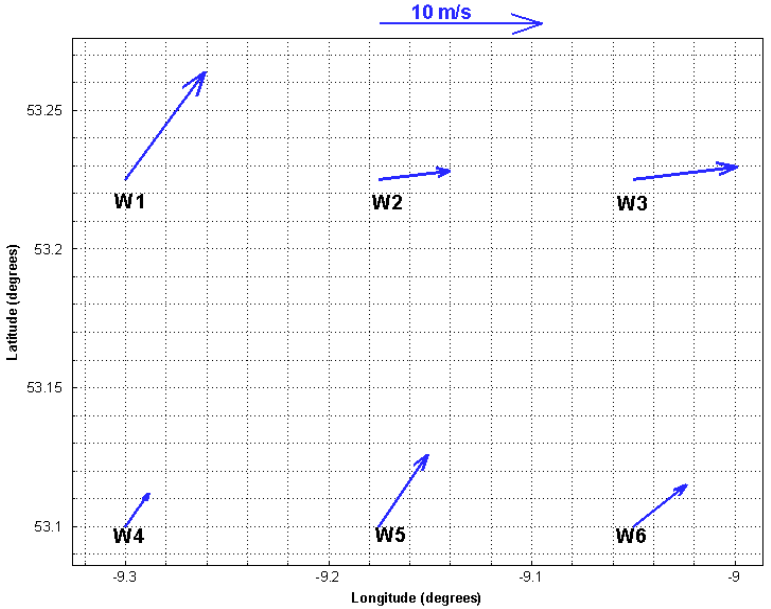
Figure 6. Mean ECMWF (European Centre for Medium-Range Weather Forecasts) wind vectors during analysis period.